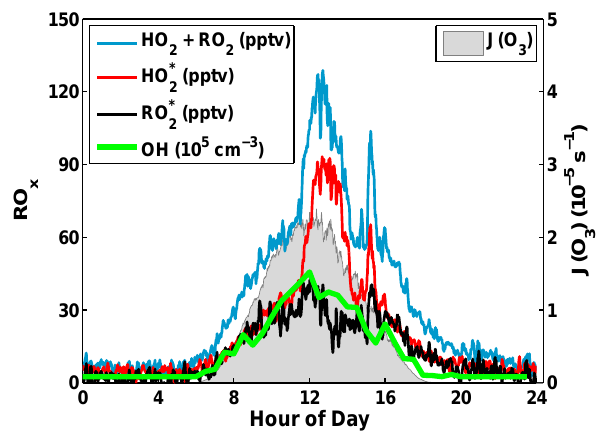
Fig. 1. Average diel cycles of total peroxy radicals (blue), HO ∗ (red), RO ∗ (black), OH (green) and ozone photolysis frequency 2 (filled gray area). Peroxy radicals and J (O 3 ) are shown as 1min means, while OH is displayed as a 30min mean. J (O 3 ) is calculated by scaling measured J (NO 2 ) with the ratio of J (O 3 )/ J (NO 2 ) cal- culated from the MCM parameterization for clear-sky conditions. Nighttime OH values were typically below the instrument detection limit (5 × 10 5 cm − 3 ) and are thus set to half of this